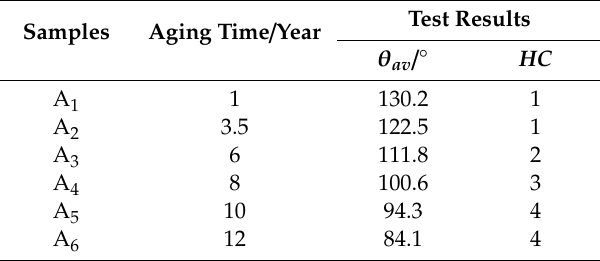
Table 1. Hydrophobicity test results on samples.